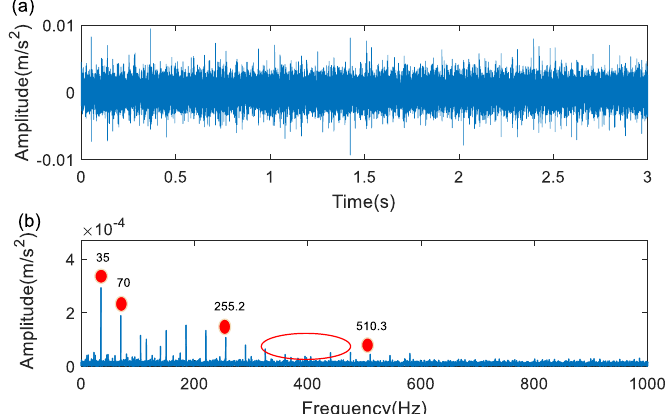
Figure 13. Results of the impulse response wavelet for inner ring fault: ( a ) the filtered signal; ( b ) its envelope